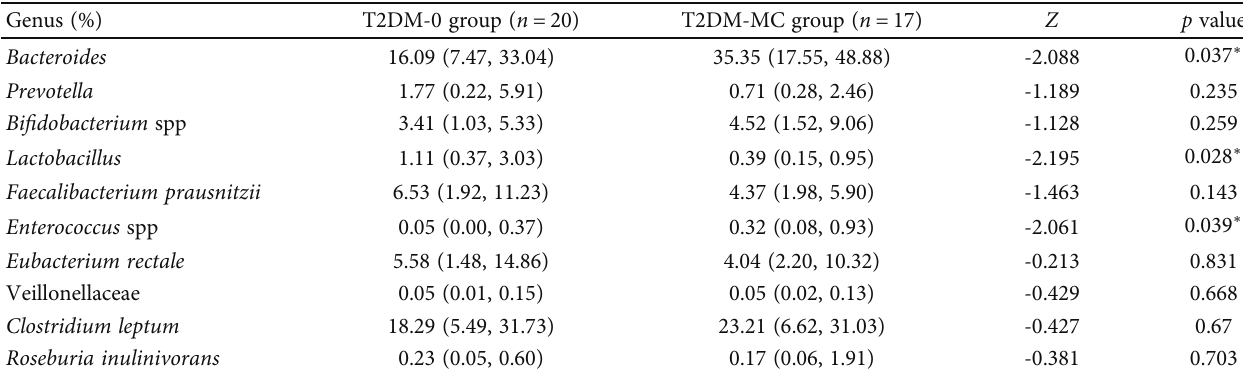
Table 3: Comparison of microbiota genus between the two